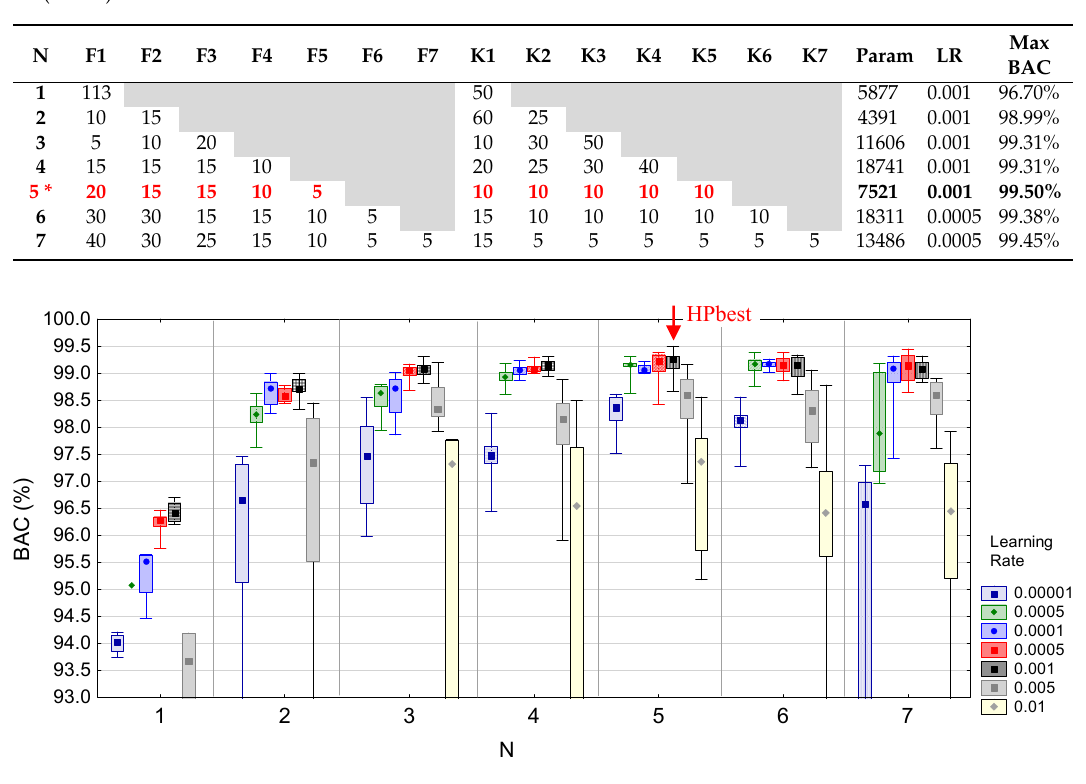
Figure 8. Validation BAC performance of HPopt models with different depths ( N = 1, 2, … 7), trained with different learning rates. The distributions are presented as median values (dots), quartile ranges (boxes) and min–max range (whiskers). The red arrow highlights the best model, i.e., N = 5 ( LR = 0.001), having BAC → max.